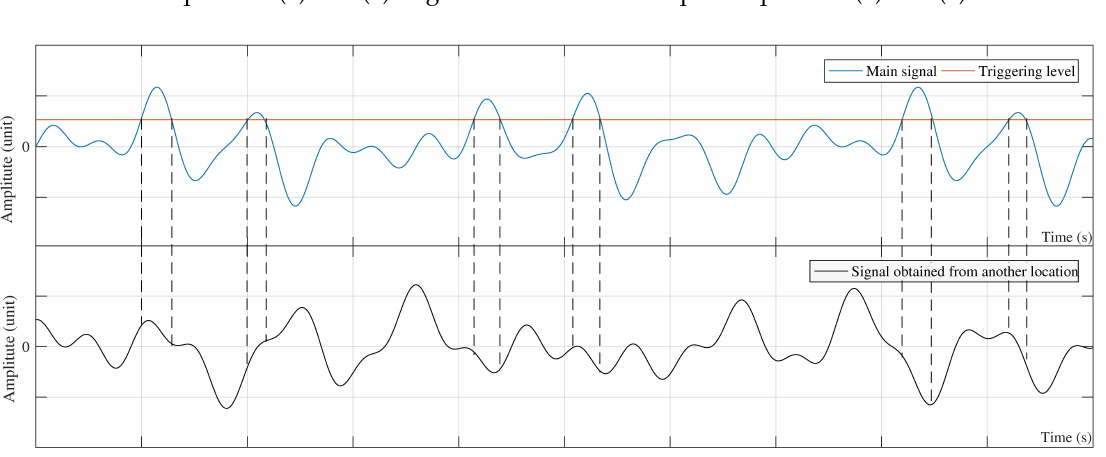
Figure 3. Concept of cross-random decrement signature (RDS)